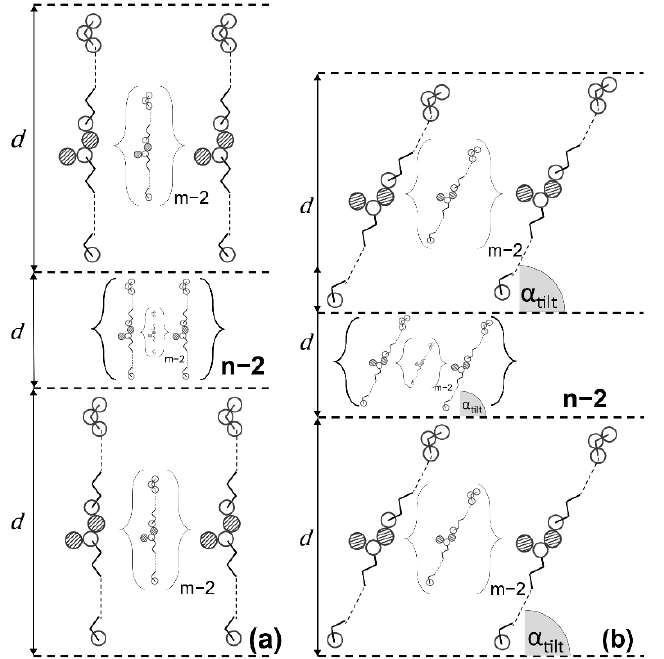
Figure 6. Schematic representation of WE molecules in unimolecular stacking: orthogonal ( a ) or tilted ( b ) chain arrangement related to the methyl end plane. White empty circles: carbon atoms, hatched circles: oxygen atoms, d = layer thickness, m = number of molecules in lateral direction, n = number of molecular layers.